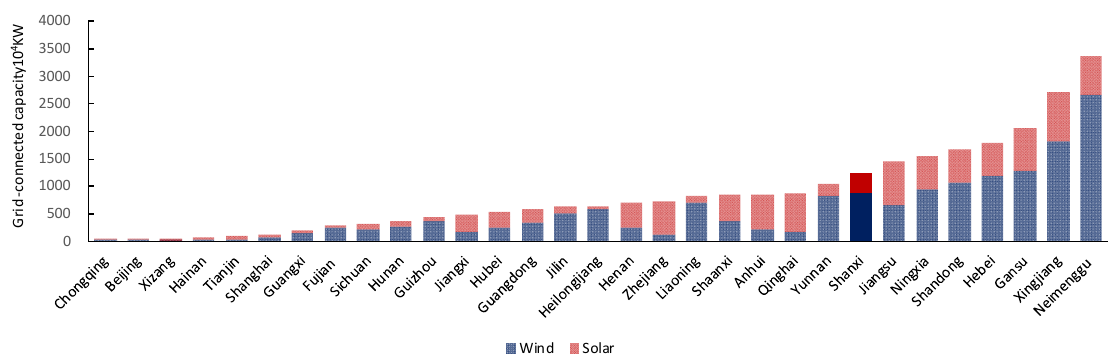
Figure 4. Accumulated grid-connected capacity of wind power and photovoltaics of China in 2017.